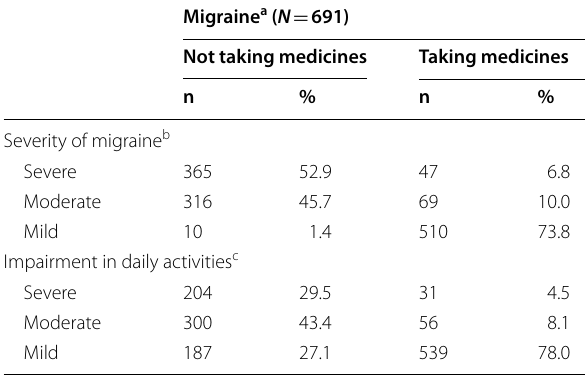
Table 7 Severity of impairment associated with medication use in migraine